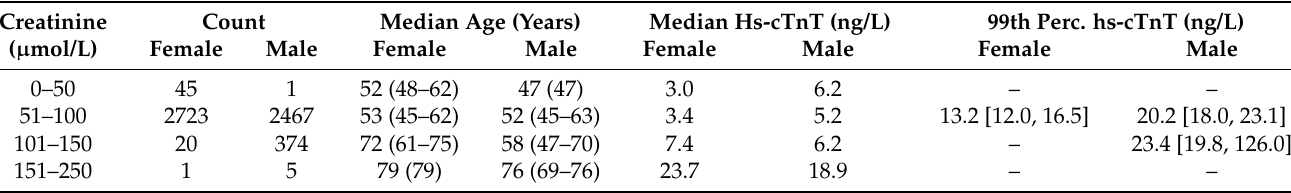
Table 3. Median and 99th percentile hs-cTnT values in relation to serum creatinine level separated by sex in study cohort 2. The number of participants and median age (with interquartile range) is provided per creatinine group. Creatinine values are binned in increments of 50 µ mol/L. 99th percentiles, and their 95% confidence intervals were provided in groups with at least 300 subjects. Increasing serum creatinine concentrations are associated with higher median hs-cTnT values and higher ages. Hs-cTnT: highly sensitive cardiac troponin T.